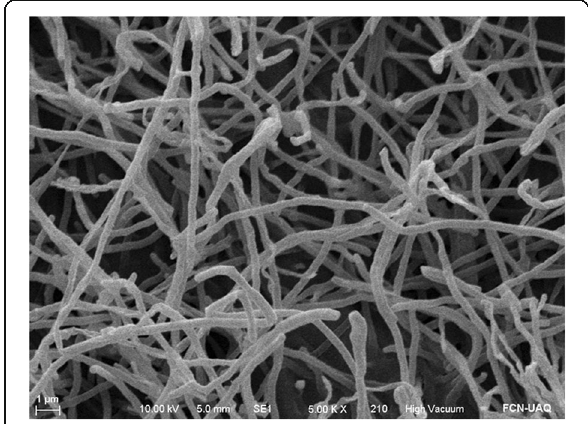
Fig. 1 Scanning electron micrograph showing spore morphology of Streptonyces sp.